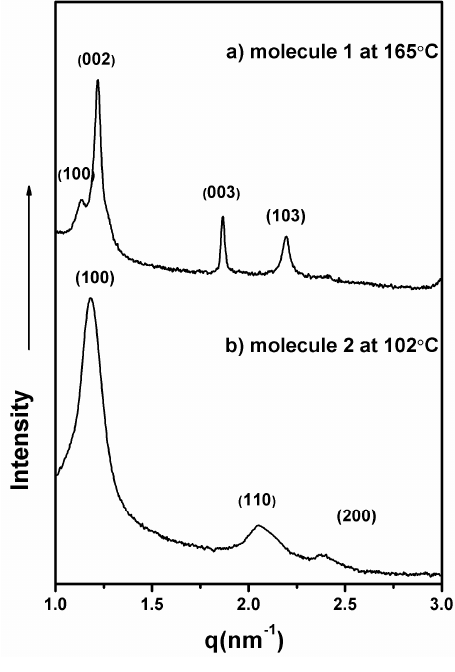
Figure 3. Small-angle X-ray diffraction patterns of 1 and 2 plotted against q .